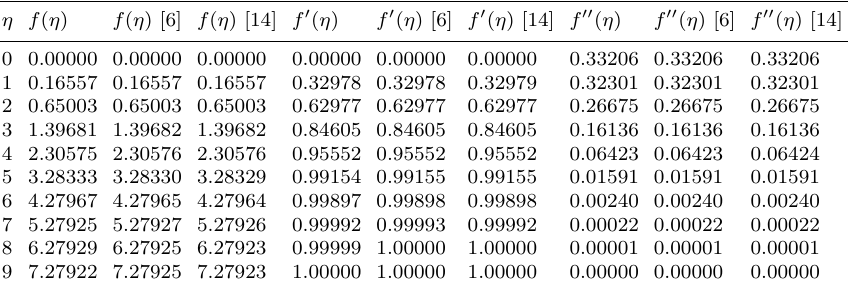
Table 1. Numerical solution of Blasius equation with β 0 = 0 . 5 and β 1 =0 compared to Howarth’s [14] and Cortell’s [6] solutions. η f ( η ) f ( η ) [6] f ( η ) [14] f (cid:48) ( η